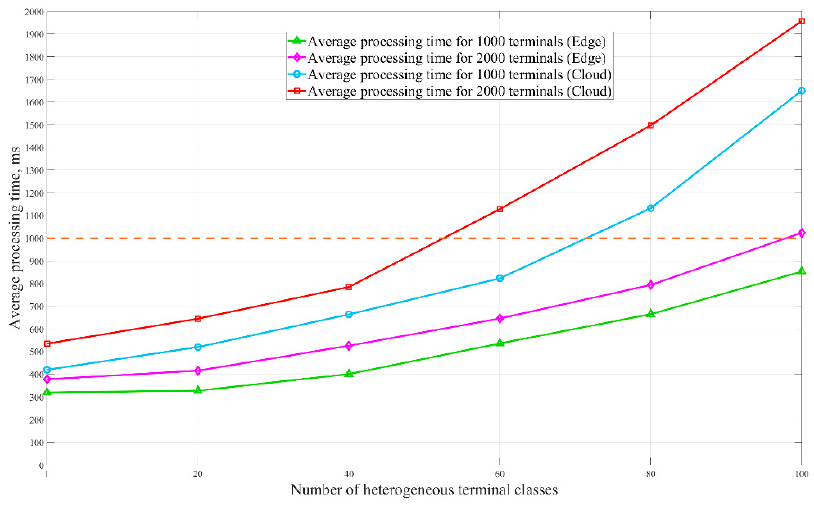
Figure 8. The processing time of situational awareness under heterogeneous